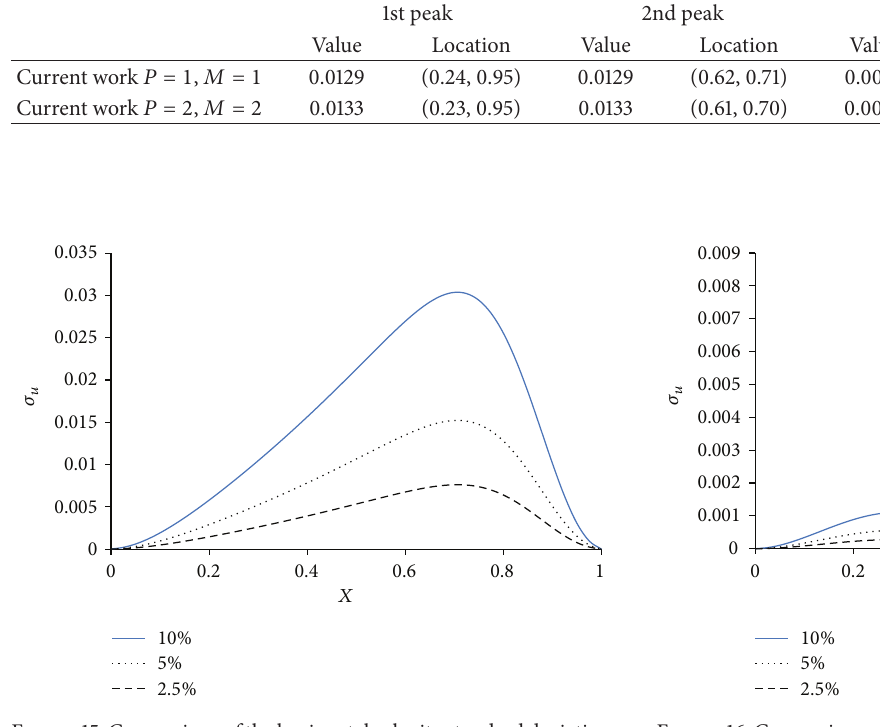
Figure15:Comparisonofthehorizontalvelocitystandarddeviation at the horizontal midline (𝑦 = 0.5) for different values of lid velocity standard deviation.